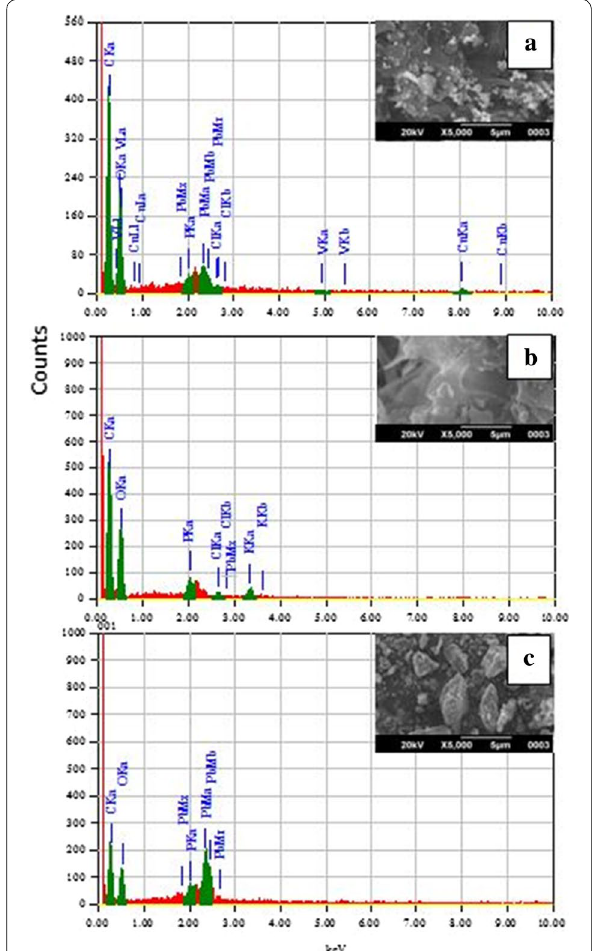
Fig. 9 SEM-EDX micrograph of Pb(II) loaded biomass of A. caespitosus ( a ) A. sp. RBSS-303 ( b ), and A. flavus HF5 ( c ) after 6 h of exposure to 100 mg/L of Pb(NO 3 ) 2 solution at pH 4.5